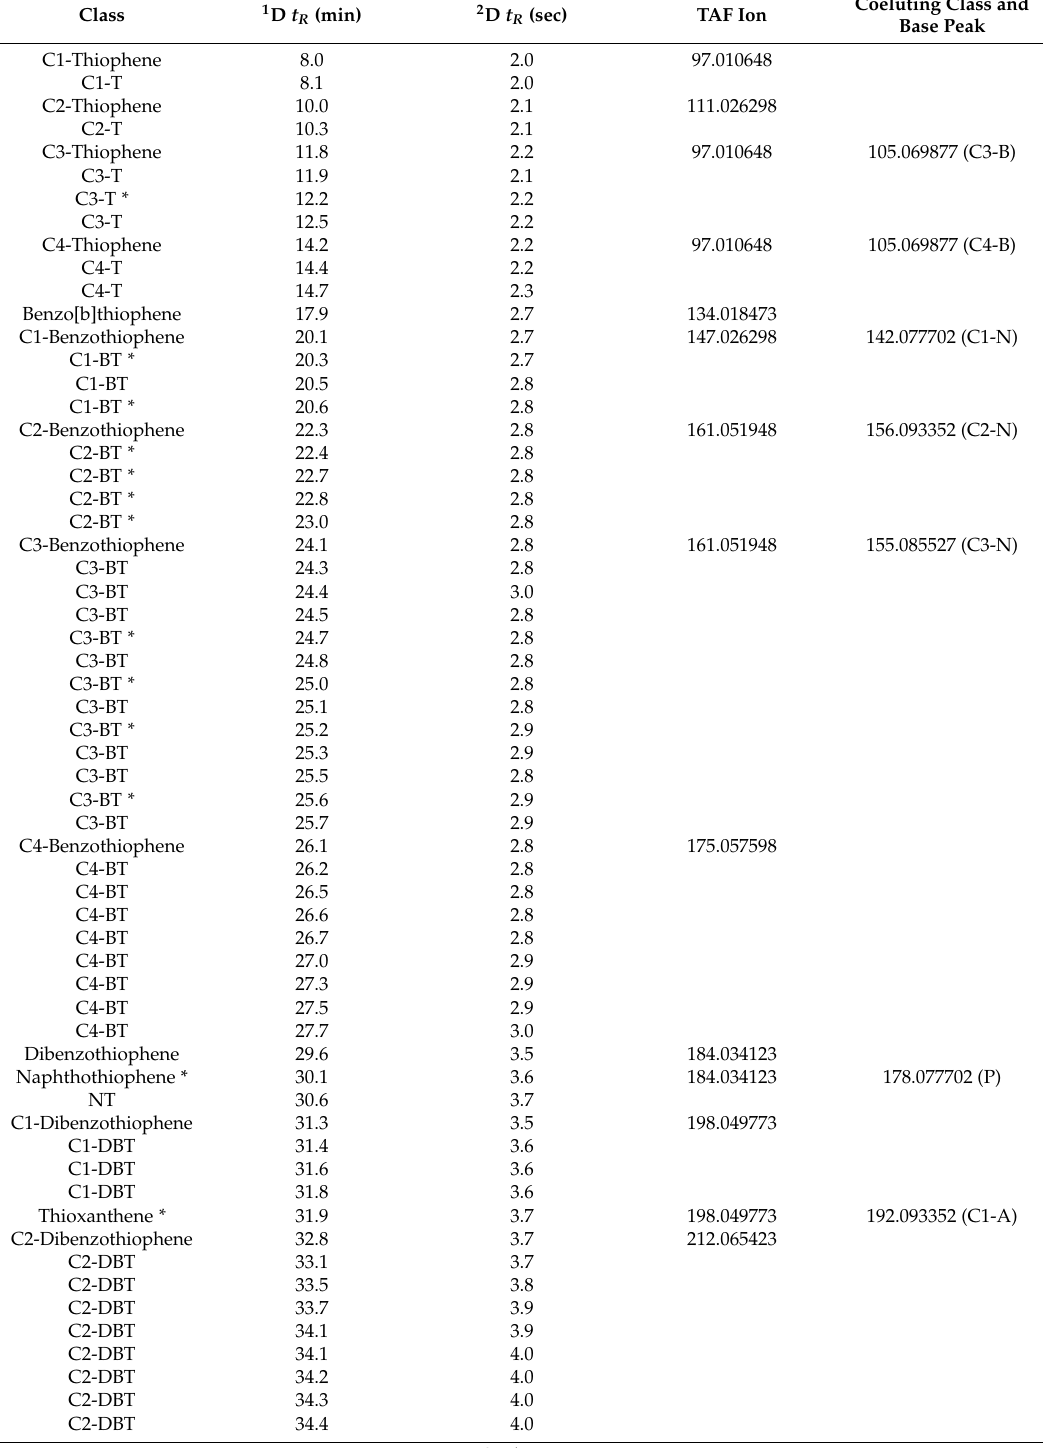
Table 2. Chemical classes, first and second dimension retention times, characteristic ion for the OSCs used for the TAF method and the base peak ion (all theoretical masses) for the coeluting compounds. Chemical class abbreviations: B = Benzene; N = Naphthalene; P = Phenanthrene; A = Anthracene; NT =